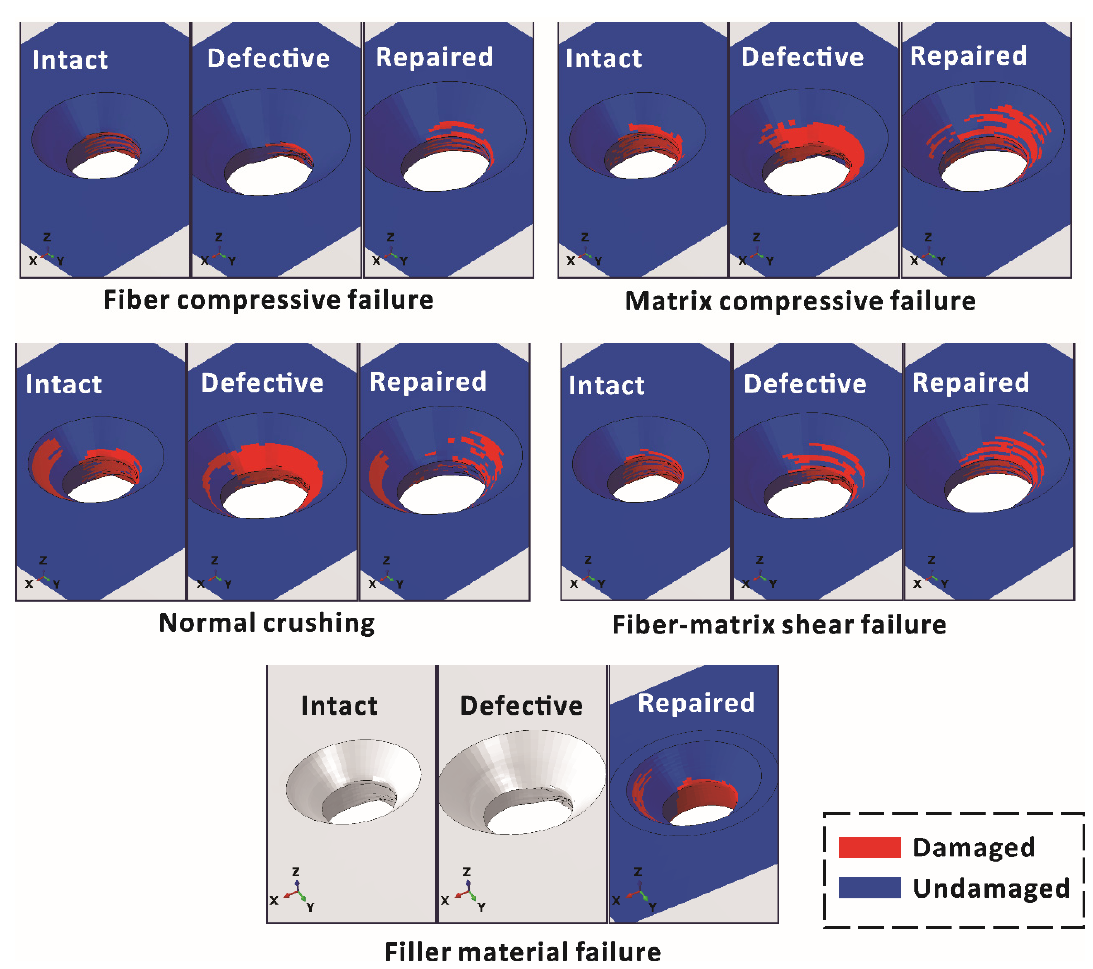
Figure 13. Simulated failure modes around the holes of upper laminates.